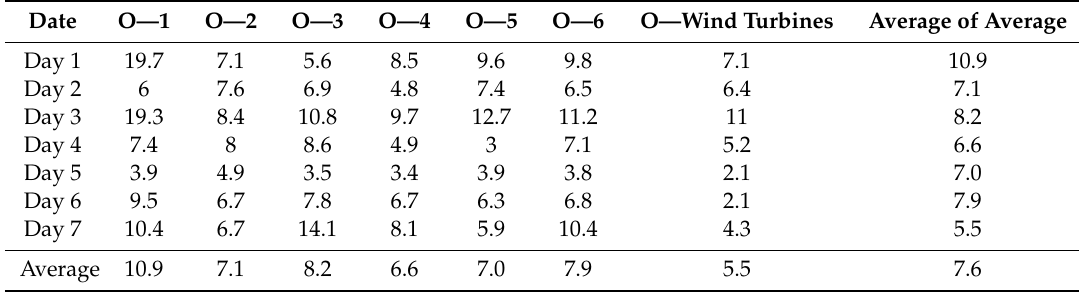
Table 2. BPP daily local and average wind